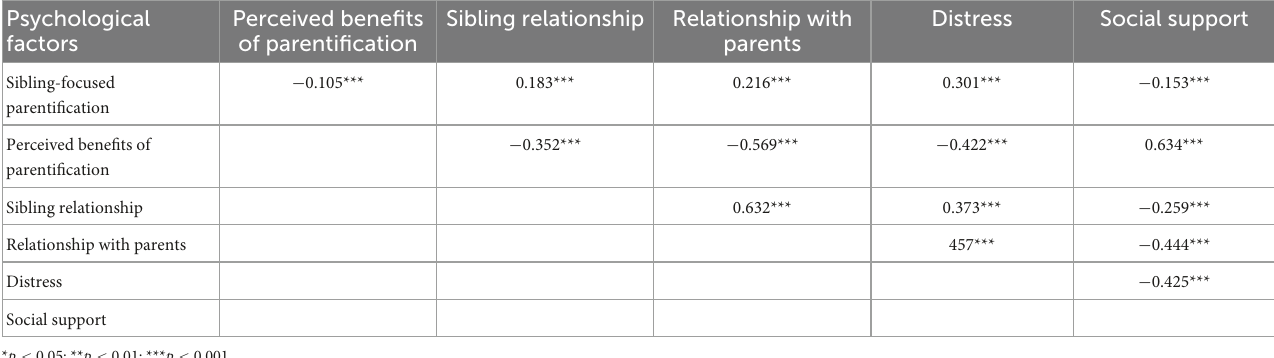
TABLE 2 Correlation between study variables.